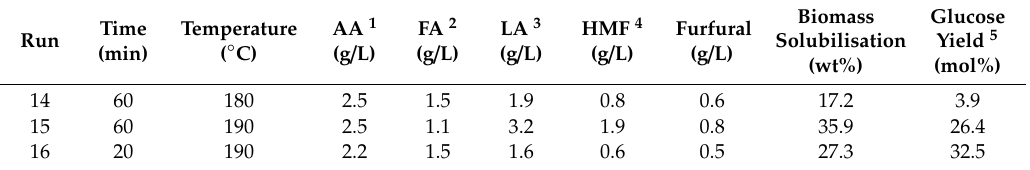
Table 5. Experimental set-up and results of cellulose hydrolysis. Reaction conditions: MW